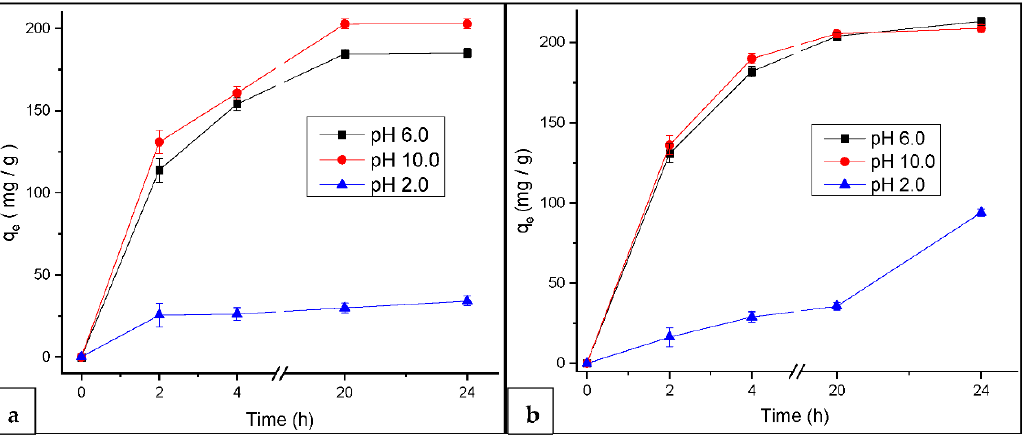
Figure 5. MB adsorption as a function of time at 37.5 °C using ( a ) SAP and ( b ) SAP-AC as adsor- bents.